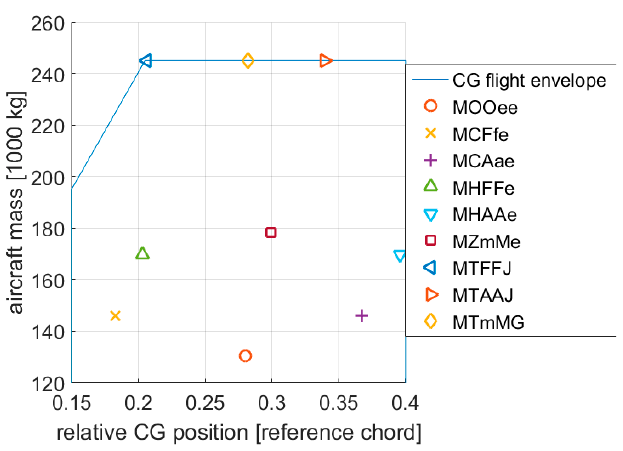
Figure 14. Overview of the mass configurations.